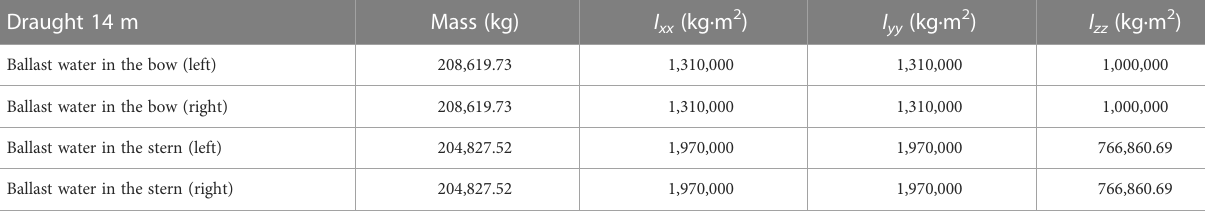
TABLE 3 Ballast water parameters under extreme survival conditions.